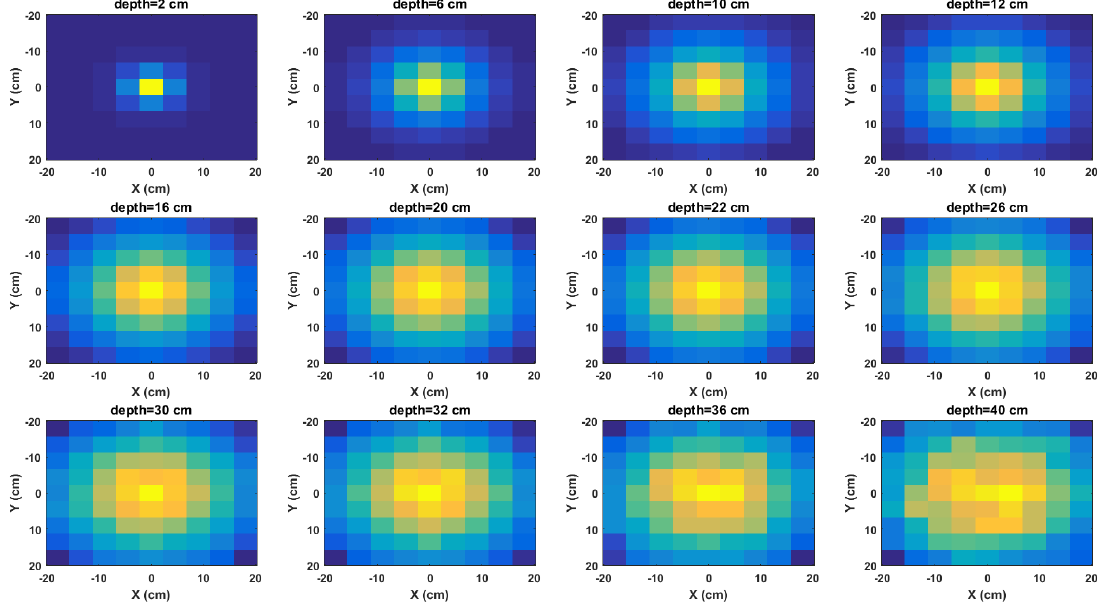
Figure 4. Normalised radiation images of Cs-137 buried in sand for selected depths. From left to right: 2 cm, 6 cm, 10 cm, 12 cm, 16 cm, 20 cm, 22 cm, 26 cm, 30 cm, 32 cm, 36 cm and 40